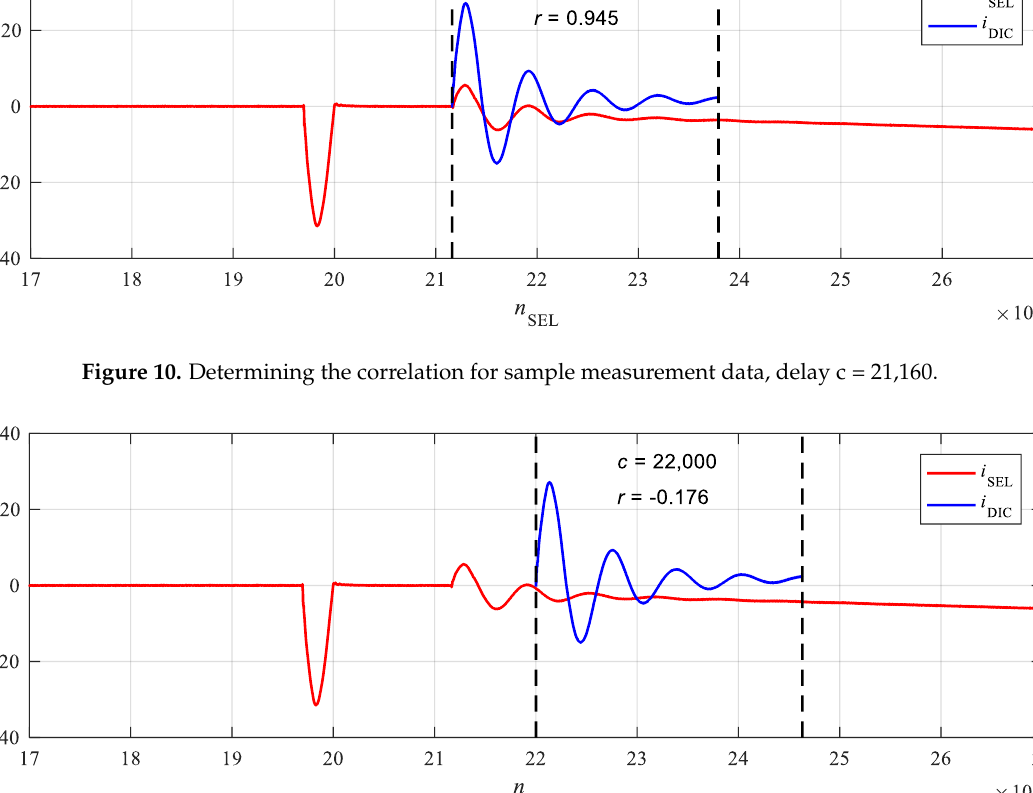
( a ) ( b ) Figure 12. Cross-correlation as a function of delay for an example of the measurement data; the whole correlation vector ( a ); the fragment of the vector r that contains the highest correlation values ( b ). 2.6. Signature Calculation The signature parameters are the maximum cross-correlation determined between the current vector SEL i and all current vectors ( ) D DIC l i from the dictionary of transients.